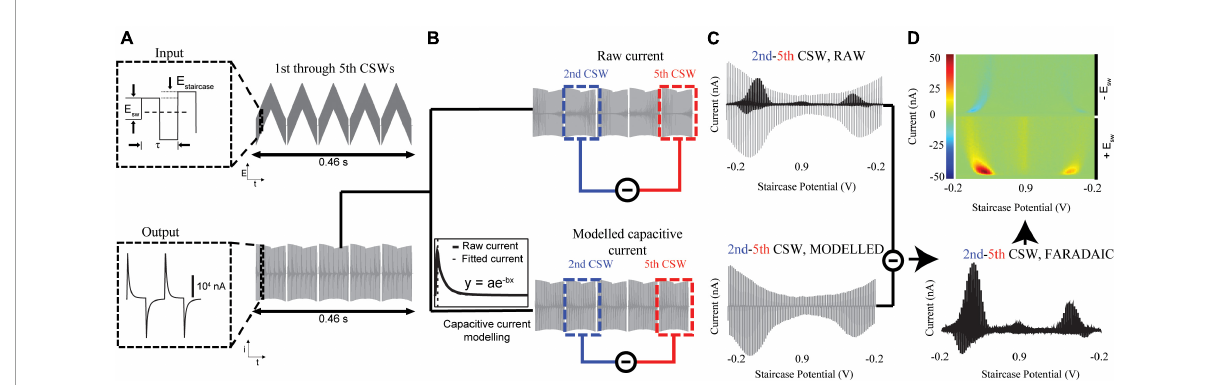
FIGURE1 Extraction of tonic neurotransmitter concentrations. (A) Top: The input cyclic square waveform, consisting of square waveforms superimposed on staircase waveforms (5 shown), is applied to the CFM. This rapidly oxidizes and reduces electroactive species around the CFM, generating current. Bottom: The output current is digitized and sent to MATLAB for processing. The remaining steps (B–D) are performed by the software. (B) The total current ( Top ) consists of the non-Faradaic capacitive current and the Faradaic current of interest. The modeled capacitive current ( Bottom) can be fit with MATLAB and subtracted away to yield the Faradaic current generated at each square wave. (C) Top: The 5th CSW is subtracted from the 2nd to remove the majority of the non-Faradaic current. Bottom: The rest of the non-Faradaic current is modeled by fitting the capacitive currents of the 2nd and 5th CSWs. The final vestiges of non-Faradaic current are eliminated by subtracting this modeled capacitive current from the true 2nd-5th CSW signal. (D) ( Bottom) What remains is the tonic Faradaic signal present at the 2nd CSW. This can then be projected onto a 3-D pseudocolor plot ( Top ) for visualization. Red represents oxidation currents and blue represents reduction currents. The left half of the color plot are currents from the upward square wave pulses, and the right half are currents from the downward